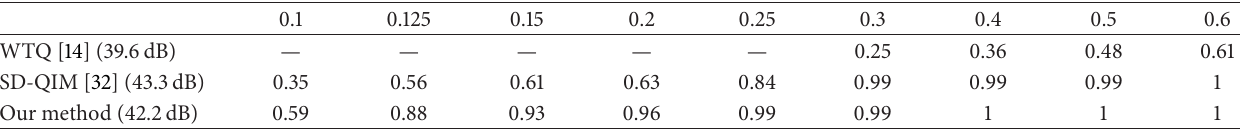
Table 3: Comparisons of robustness against JPEG2000 compression.